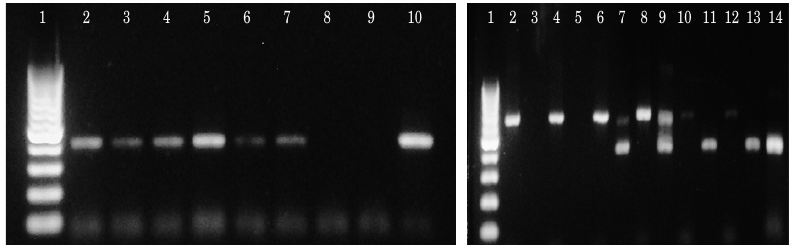
Figure 3. PCR amplification from inoculated plants. A) Amplification carried with CLO1F/CLO1R primers. Lane 1, 100 bp DNA Marker; lanes 2 – 7, plants inoculated with C. luteo-olivacea ; lanes 8–9, plants inoculated with ster- ile agar discs; lane 10, C. luteo-olivacea genomic DNA. B) Amplification carried with GU2F/GU2R. Lane 1, 100 bp DNA Marker; lanes 2 and 4, PCR products obtained with ITS4/ITS5 from plants inoculated with sterile agar plugs; lanes 3 and 5, nested PCRs carried out with GU2F/GU2R; lanes 6, 8, 10, 12, PCR products obtained with ITS4/ITS5 from plants inoculated with G. uvicola ; lanes 7, 9, 11, 13, nested PCR carried with GU2F/GU2R; lane 14, G. uvicola genomic DNA amplified with GU2F/GU2R.